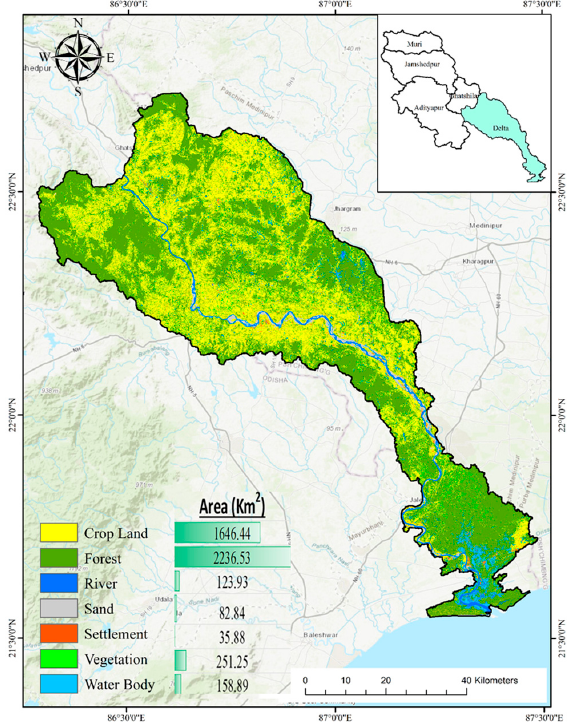
Figure A2. LULC (Land use and Land cover) map of Delta sub-basin (Based on: earthexplorer.usgs.gov (accessed on 2 May 2022)).